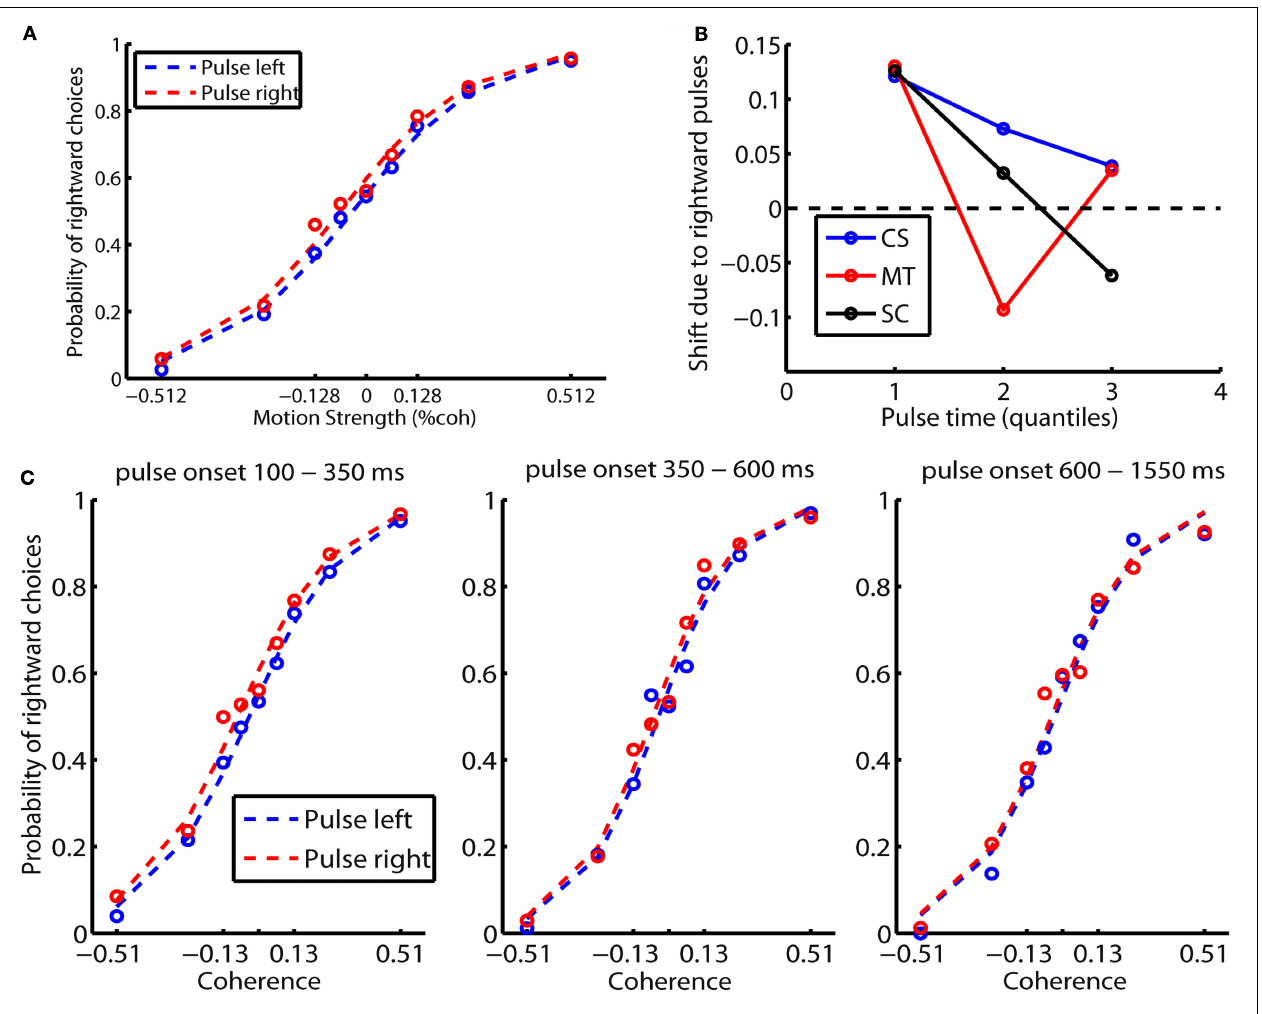
(B,C) The effect size of the shift varies with the time of the pulse. (C) The psychometric function of participant CS as the pulse comes early, intermediate and late in the trial. (B) The effect size of the pulse in the unit of the equivalent motion coherence as a function of pulse time for all of the three